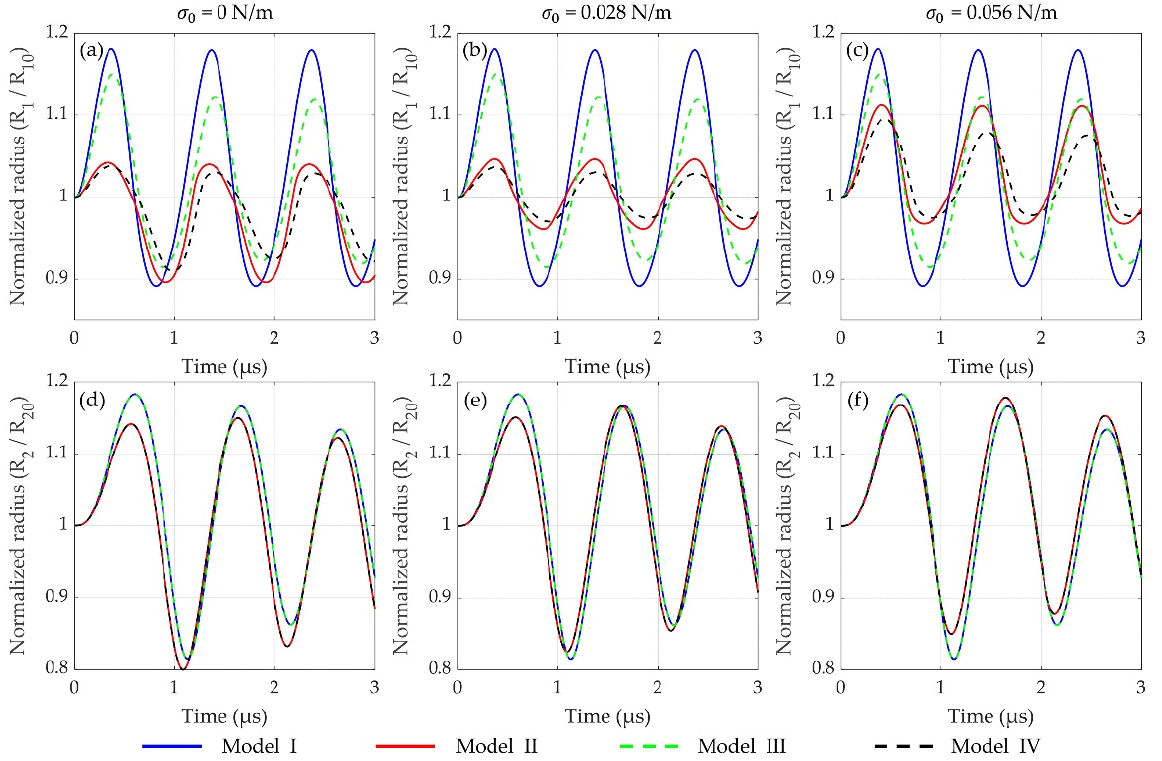
Figure 2. Bubble dynamics of two microbubbles ( R 1 and R 2 ) in the viscoelastic tissue predicted by different models (I–IV) at different values of initial surface tension σ 0 ( p A = 100 kPa). ( a – c ) Normalized radii of a small bubble ( R 1 ) with an initial radius of R 10 = 1 µ m and ( d – f ) a large bubble ( R 2 ) with R 20 = 5 µ m as a function of time. Model I and model II represent uncoated and lipid-coated microbubbles without considering bubble–bubble interactions, respectively, whereas model III and model IV represent the corresponding cases with considering bubble–bubble interactions at d i,j = 20 µ m.